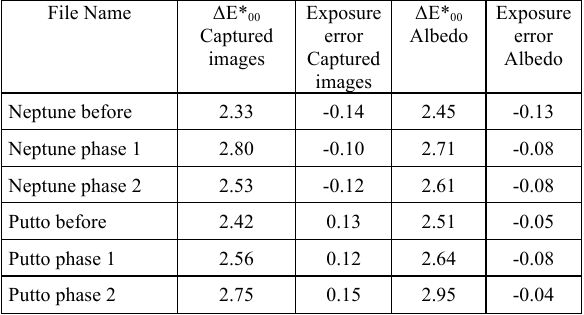
Table 4. Δ E* 00 and exposure error (in f-stops) evaluation.